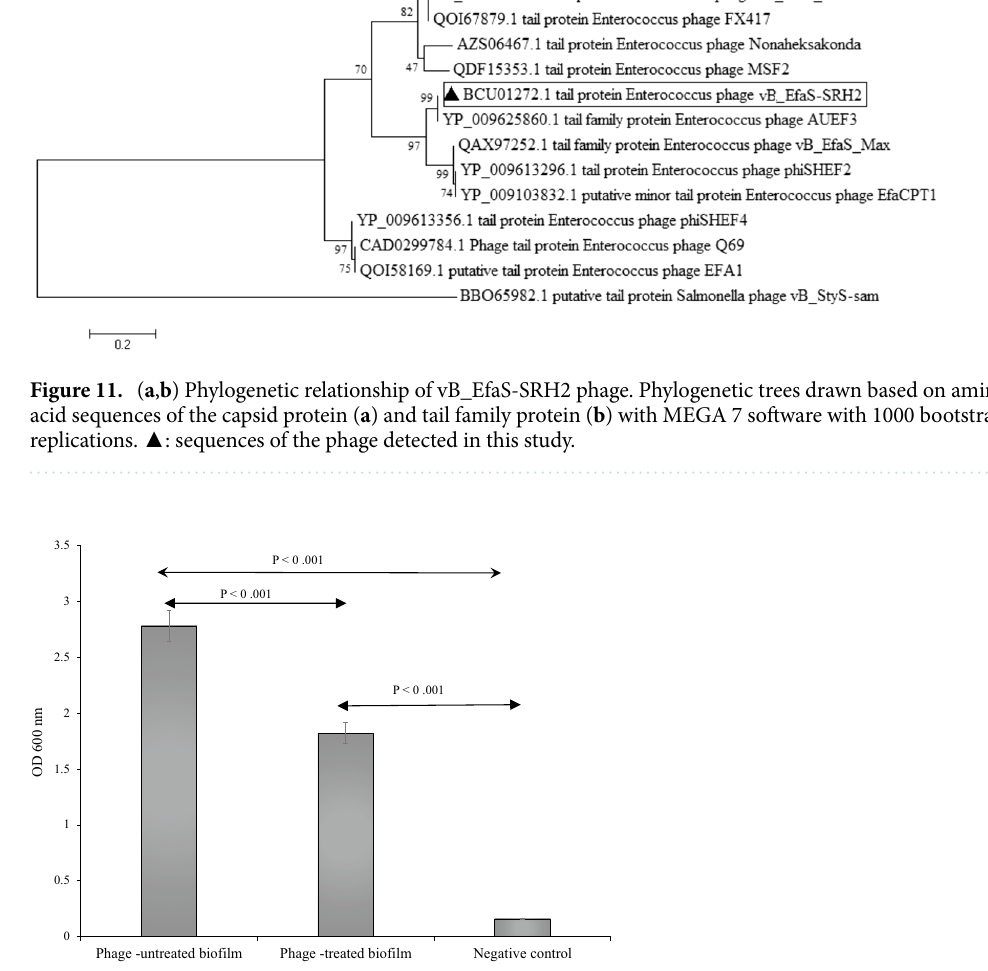
Figure 12. The effect of the phage vB_EfaS-SRH2 on the biofilm mass of E. faecalis . The assay was performed in triplicate in wells of polystyrene microtitre plates. Error bars indicate standard deviations. P values < 0.05 were considered